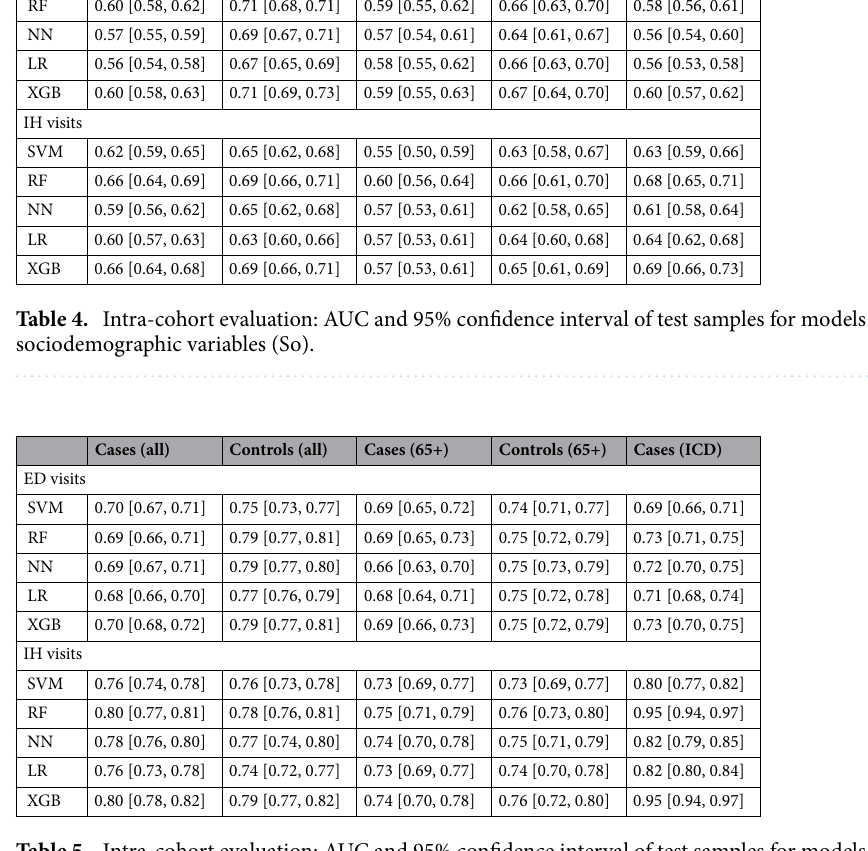
Table 4 includes the AUC of the models that use only the sociodemographic (So) variables. The AUCs and the 95% confidence interval using bootstrapping are obtained over the test datasets. The top section of the table is dedicated to ED visits while the bottom section reports the classification results for IH visits. The AUC for the ED cases models varies between 0.56 and 0.60 compared to a range between 0.67 and 0.71 for the ED control models. A slight drop in performance is observed when the patient population is limited to the age group 65+ for both cases and controls. This drop may be due to the difference in number of samples used in the (all) and the (65+) models. Table 4 also shows that the AUC of the models induced by the (all) cases and (ICD) cases cohorts are comparable despite the lower number of samples used to develop the latter models. Moreover, the results in Table 4 indicate that the (all) cases and controls models have a confidence interval (CI) with a range less than 6% whereas for the 65+ models, the CI range is greater than 6% indicating that the (all) models have a higher level of certainty. Similar trends are observed for the IH visits. The AUC of the models that use the disease conditions variables (Dx) in addition to the So variables are reported in Table 5. When compared to the So-only counter-part models (Table 4), the results show an improve- ment in AUC for all models. The increase in AUC is 0.10 or higher for most models. The cases (ICD) models benefited from the highest improvement with an increase of more than 0.15 in AUC. This increase in performance is attributed to the added entropy from the disease conditions modality. The CI range of the models after the addition of the Dx modality is consistent with the baseline So model. Moreover, the ED cases models (columns 1 and 3) still have a lower performance than the ED controls models (columns 2 and 4). For the IH visits, with the addition of the Dx variables, the cases models show higher AUCs than the corresponding controls models. The opposite was true for the models that only used the So variables. The best IH models are the (ICD) cases models with AUCs ranging between 0.80 and 0.95 for all ML techniques. The performance of the models that combine the So variables with the ATC medication groups variables (Rx) is shown in Table 6. Compared to the baseline So models (Table 4), the addition of the Rx variables leads to an increase in performance similar to that observed after the addition of the Dx variables. Moreover, most of the trends observed with the addition of the Dx variables are maintained when the So variables are combined with the Rx variables. The predictive performance of the models in Table 5 is also equivalent to that of the corresponding